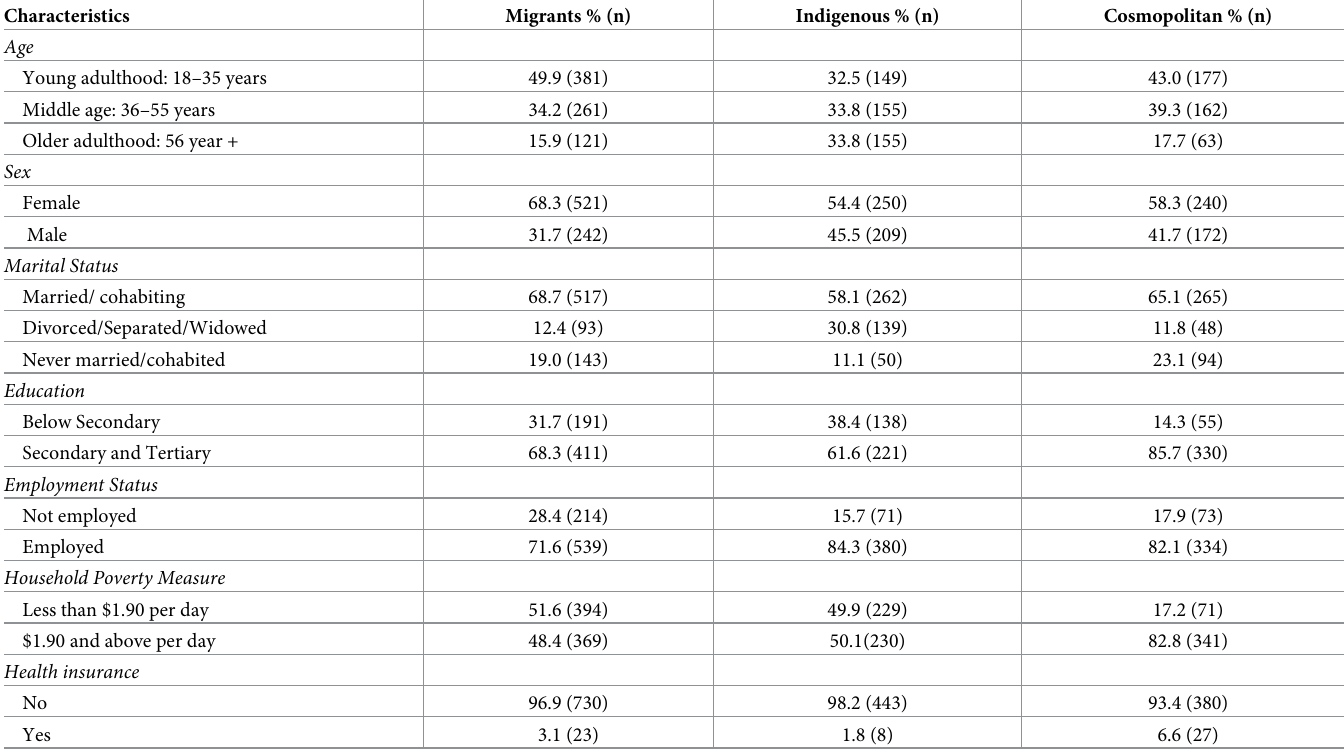
Table 1. Percentage distribution of population characteristics of participants who needed and sought healthcare in the selected urban slums in Nigeria. Characteristics